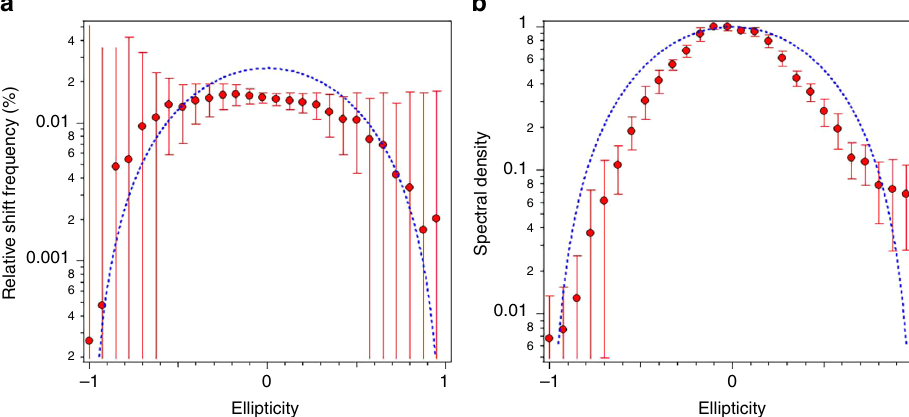
Fig. 3 Polarization dependence. We show the dependence of the third harmonic blue-shift ( a ) and intensity ( b ) as a function of ellipticity of the impinging light. Measurements (symbols with error bars) are compared with MDF simulations (solid curves). The measurement errors are derived from the instrument measurement uncertainties, i.e., from the spectrometer and power meter